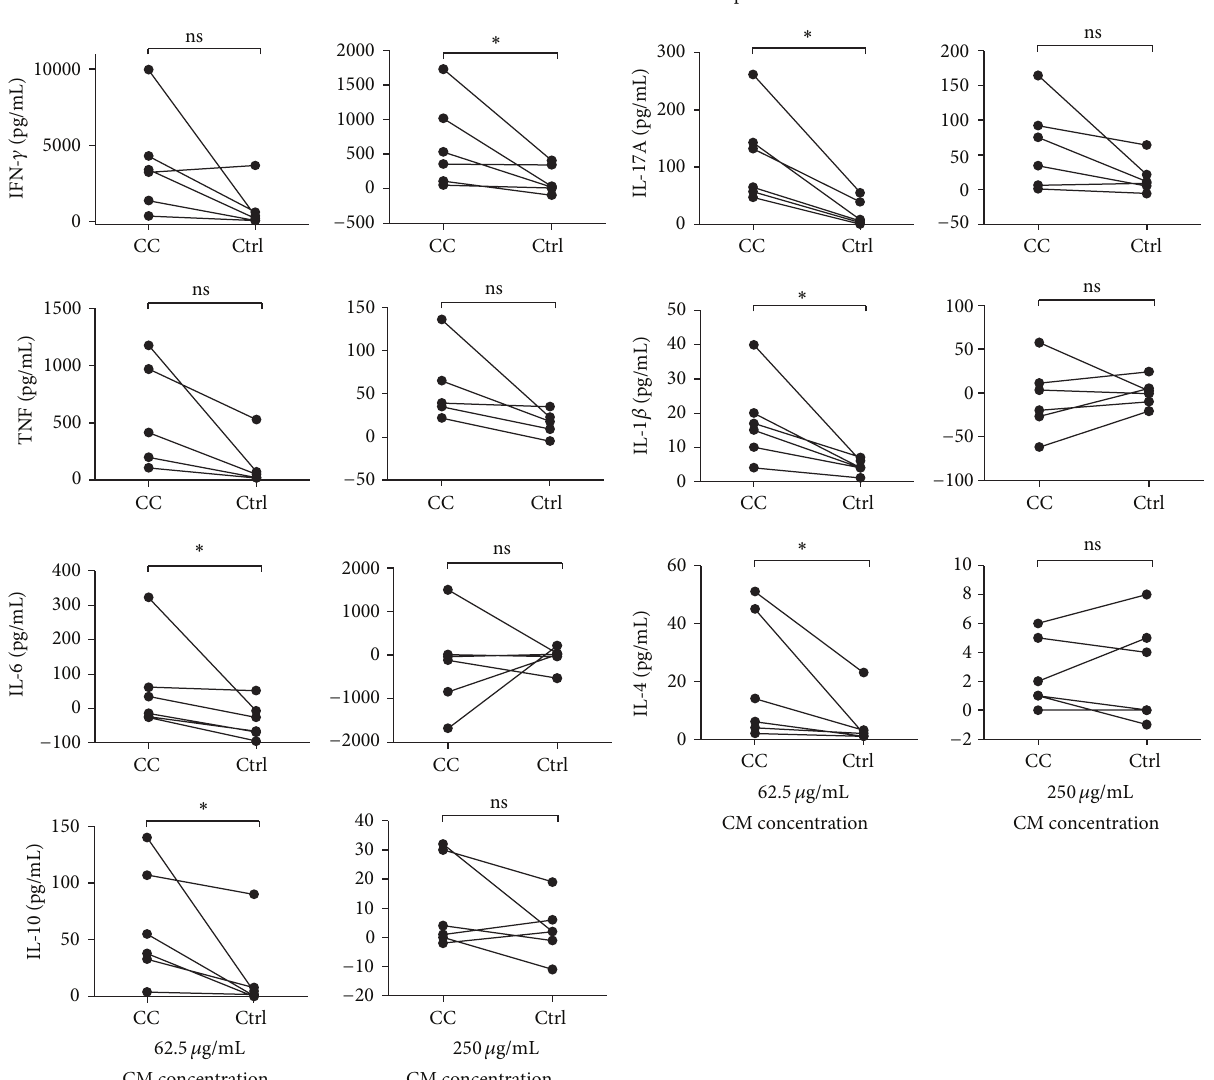
Figure 1: Luminex analysis for IL-1 𝛽 , IL-4, IL-6, IL-10, IL-17A, IFN- 𝛾 , and TNF production by anti-CD3 plus anti-CD28 stimulated CD4 +